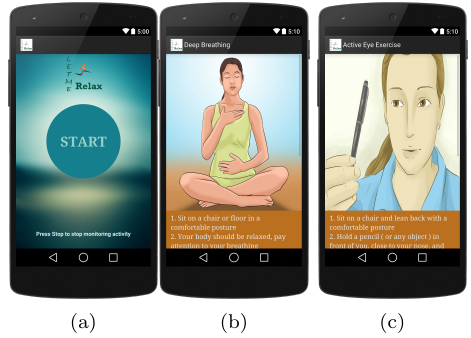
Figure 1: Let Me Relax pebble watch application states: (a) Home (b) Activity Tracking (c) Notification